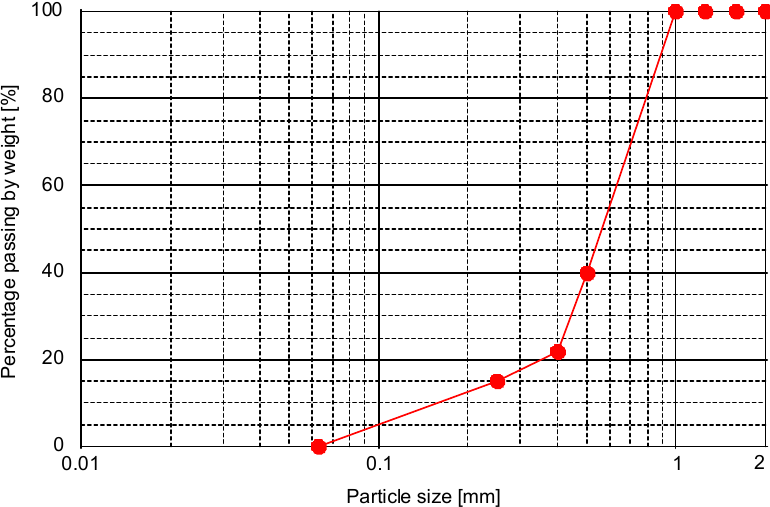
Figure 2. Sand grading curve.